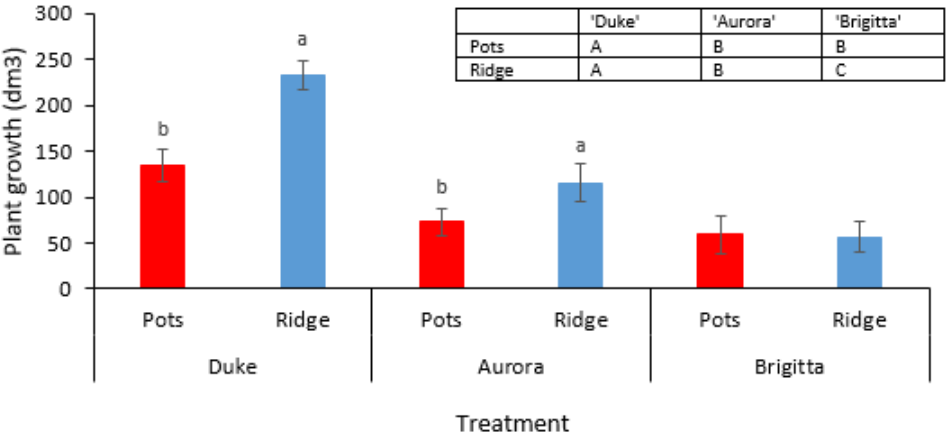
Figure 3. Plant growth for the ‘Duke’, ‘Aurora’, and ‘Brigitta’ blueberry cultivars grown in pots and along the ridge. Different lowercase letters indicate statistically significant differences between planting methods within cultivars ( t -tests, α < 0.05), and different uppercase letters (inset) between cultivars within planting methods (LSD tests, α < 0.05).